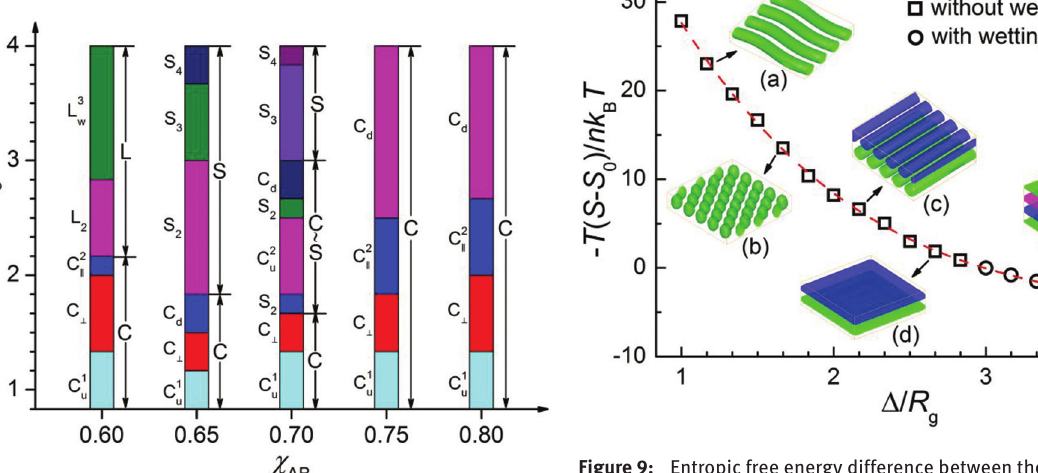
Figure 9: Entropic free energy difference between the confined thin film (– TS ) and the bulk of dendrimer copolymer (– TS of film thickness Δ/ R